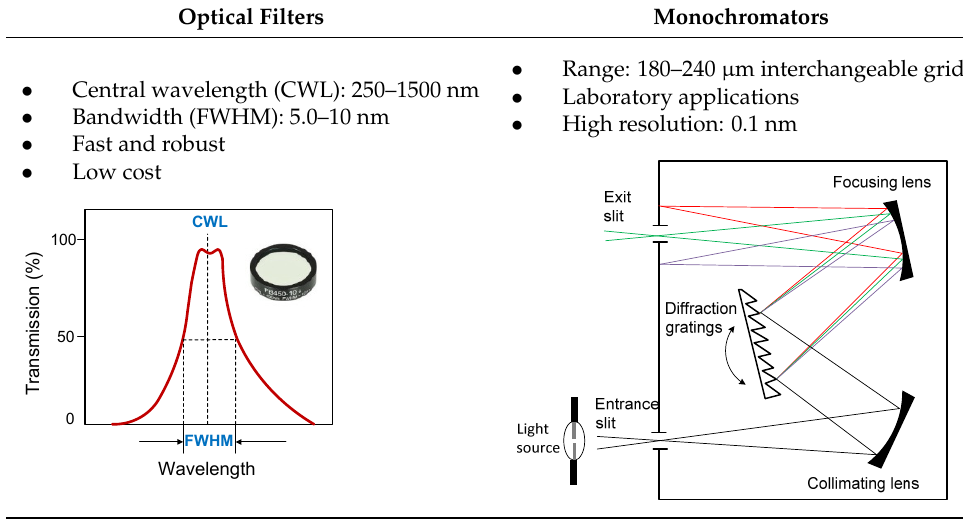
Table 3. Wavelength selector devices used for optical chemical (bio)sensing.